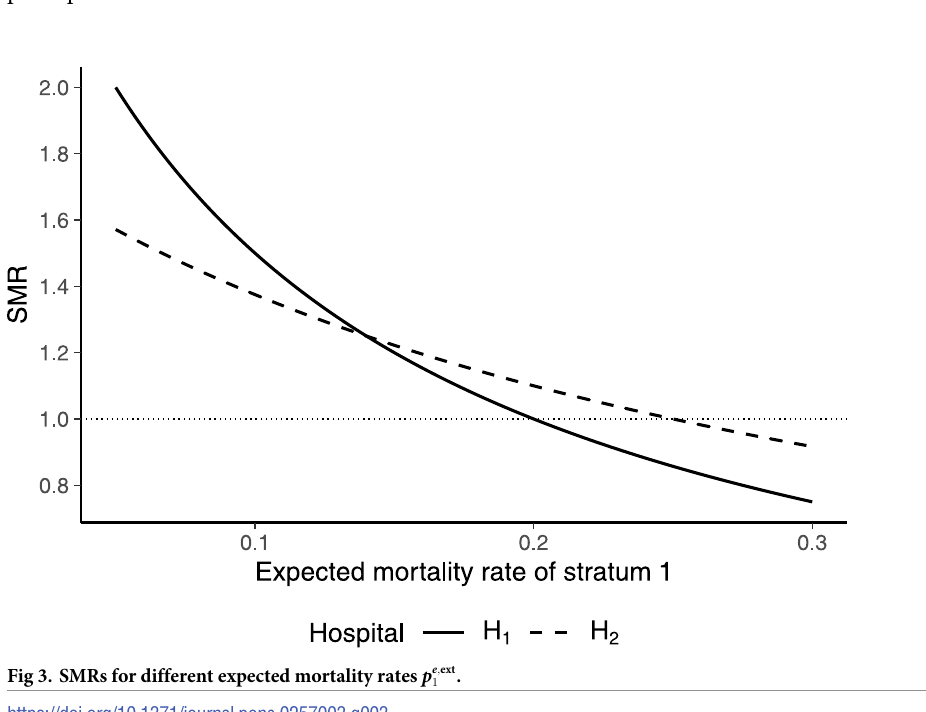
Fig 3. SMRs for different expected mortality rates p e ; ext